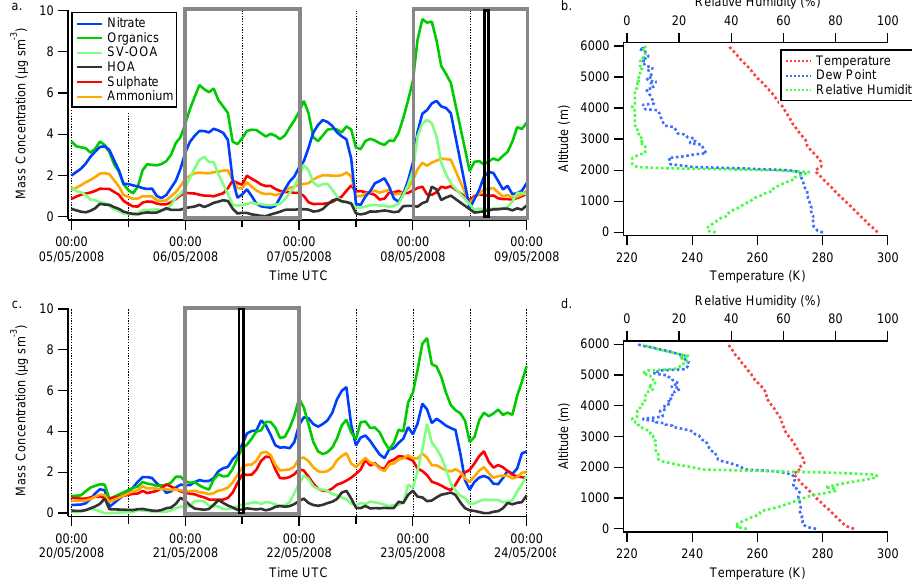
Fig. 3. Panels (a) and (c) display time series of AMS mass concentrations from Cabauw from 5–9 May 2008 and 20–24 May 2008, respectively. The Semi-Volatile Oxygenated Organic Aerosol (SV-OOA) and Hydrocarbon-like Organic Aerosol (HOA) components are also shown. The grey boxes indicate days when the BAe-146 conducted flight operations in the vicinity of Cabauw, while the black boxes indicate the time periods when the BAe-146 was within 50km of Cabauw during B366 and B379. Panels (b) and (d) display the temperature and relative humidity profiles derived from radiosonde launches from Cabauw at 16:04 UTC on 8 May 2008 and 12:01 UTC on 21 May 2008